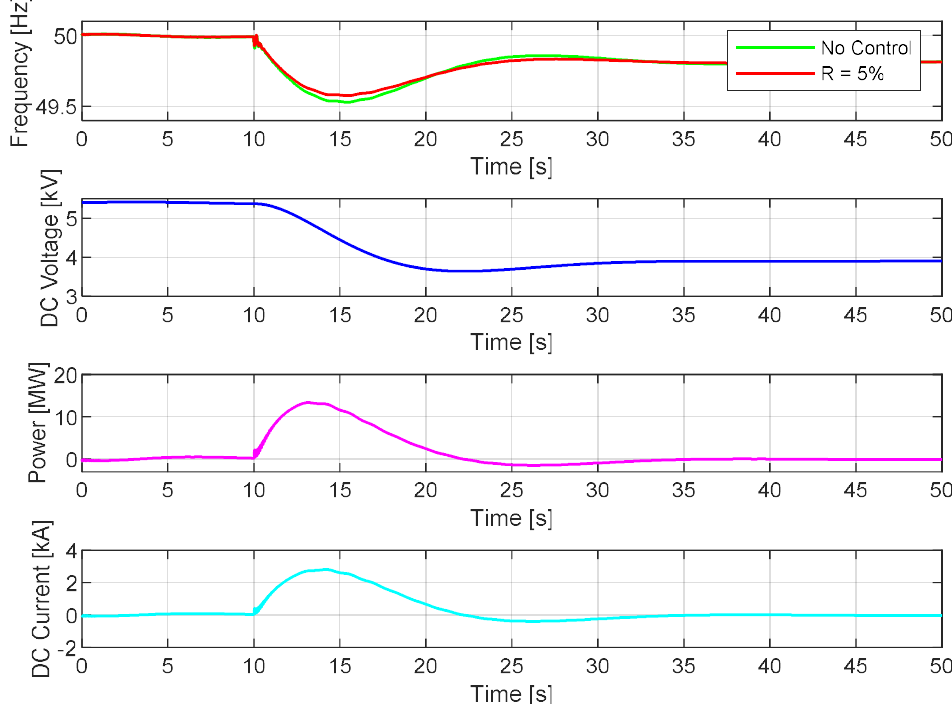
Figure 8. FFR provision from the converter-connected SC (from top to bottom: system frequency, SC terminal DC voltage, SC output DC power, SC output DC